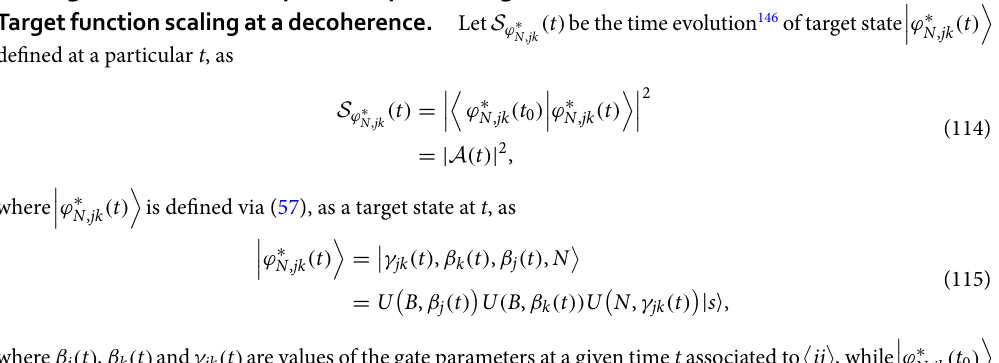
in the distributed system N j